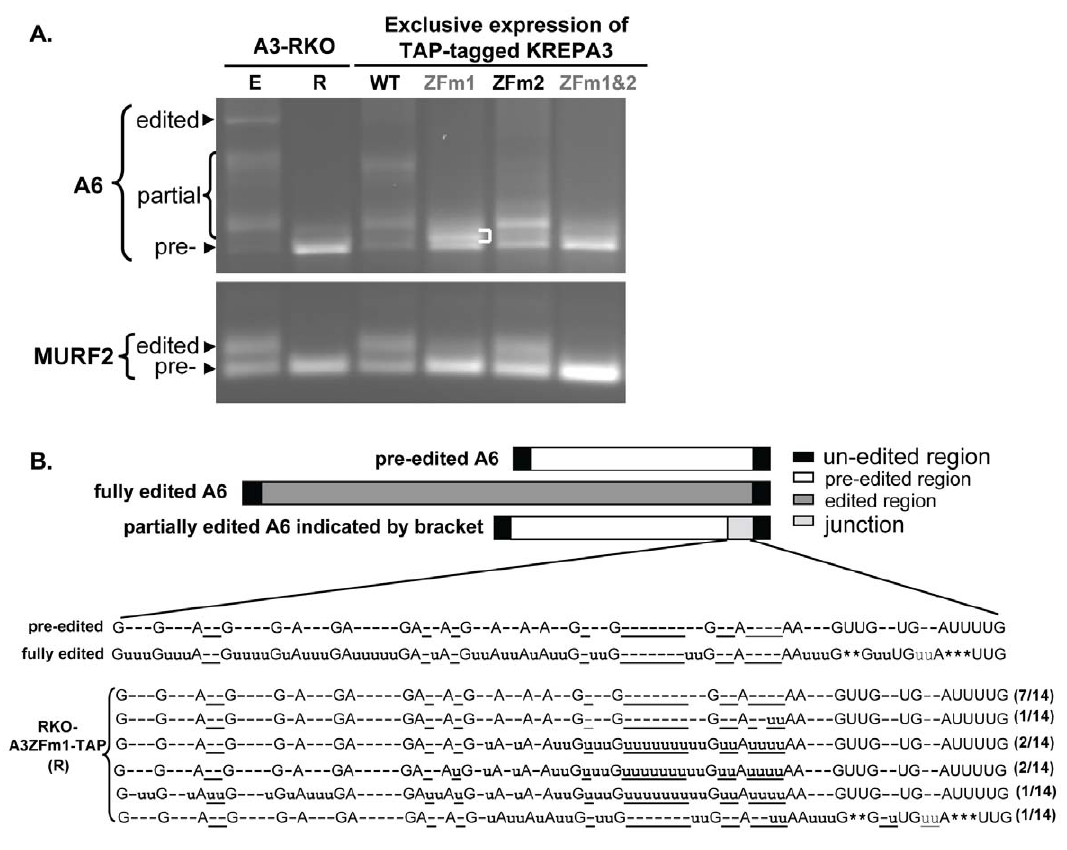
Figure 5. Effect of ZF1 mutation in KREPA3 on RNA editing progression. ( A ) Agarose gel analysis of A6 and MURF2 mRNAs RT-PCR products from cells that exclusively expressed WT TAP-tagged KREPA3 or mutants with one or both ZFs mutated (see [49]). RT-PCR products from KREPA3-RKO cells with KREPA3 expressed (E) or repressed (R) were used as controls. ( B ). Sequence analysis of gel isolated partially edited A6 mRNAs that accumulated (indicated by bracket) upon mutation of KREPA3 ZF1. The location of the partially edited junction is shown schematically. Sequence designations as in Figures 3 and 4.